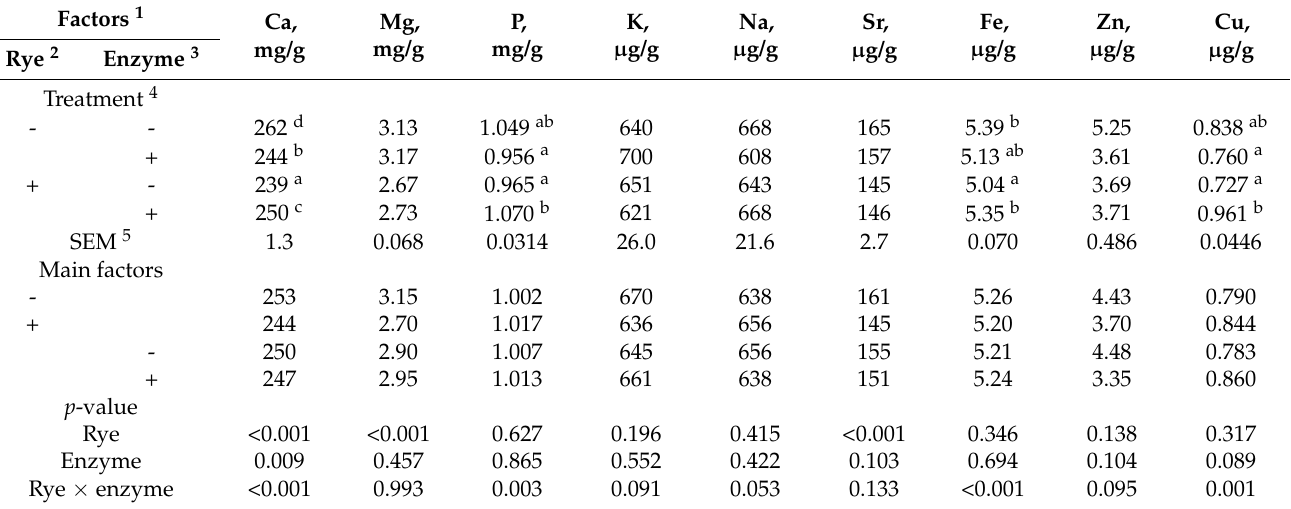
Table 3. Effect of dietary 25% rye inclusion and xylanase supplementation (200 mg/kg of feed) on eggshell mineralization at the end of the laying